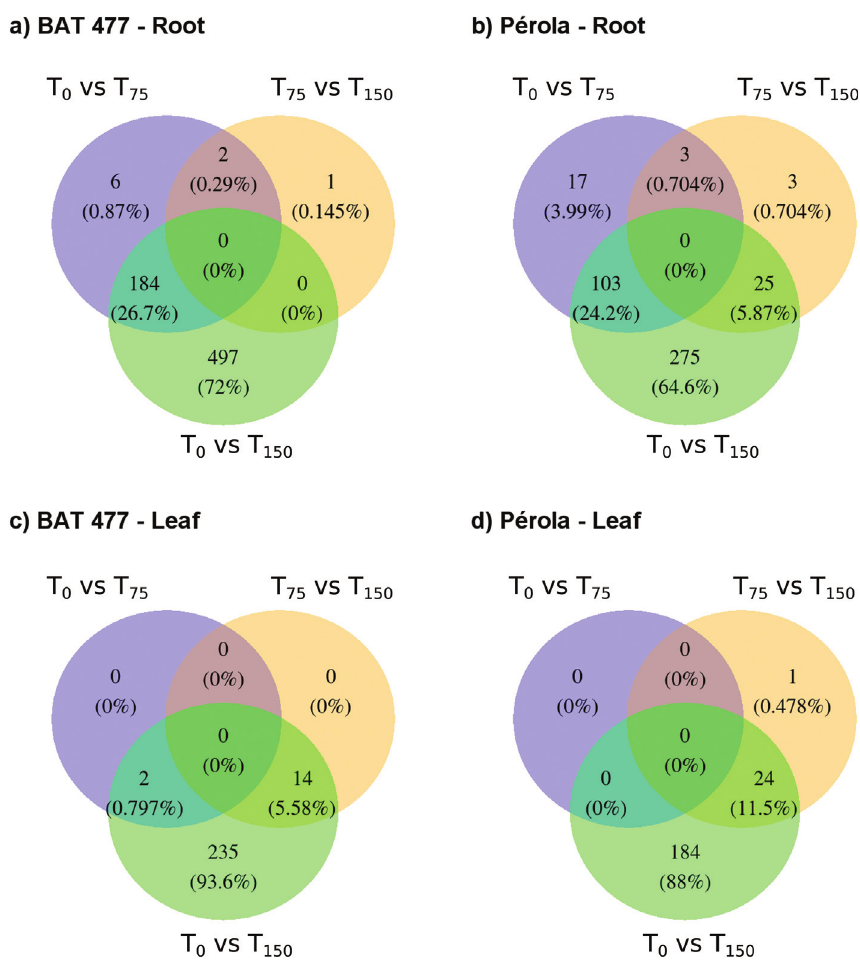
Figure 1 - Differentially expressed genes between treatments for each genotype and tissue. (a) DEGs from BAT 477 in the root; (b) DEGs from Pérola in the root; (c) DEGs from BAT 477 in the leaf; (d) DEGs from Pérola in the